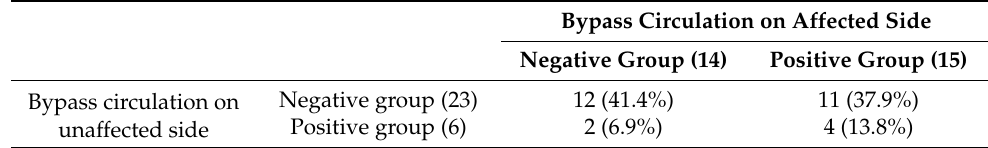
Table 2. Occurrence of bypass lymphatic nodes on the affected and unaffected